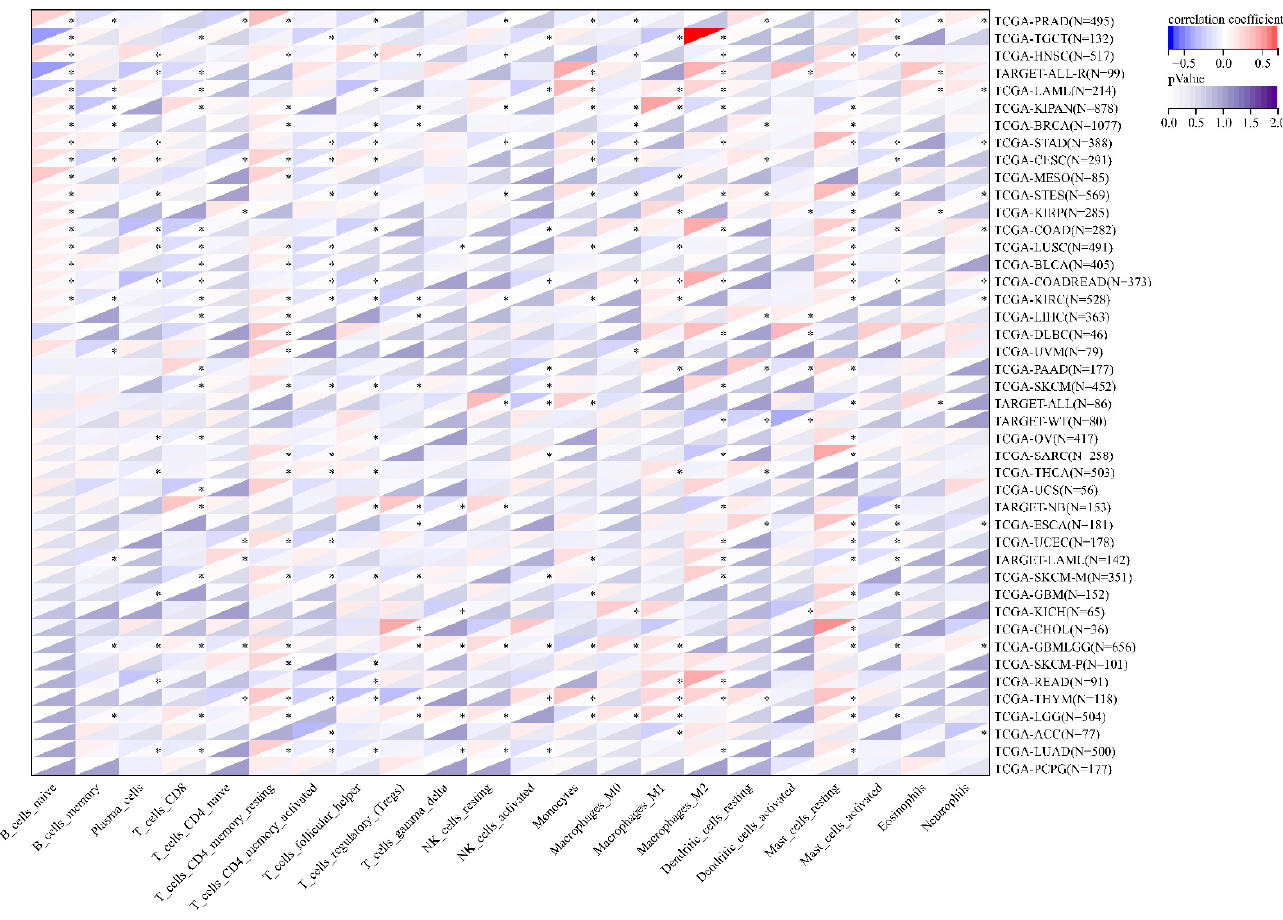
Figure 7. The correlation matrix between MEIS1 expression and immune cell content. * p < 0.05.